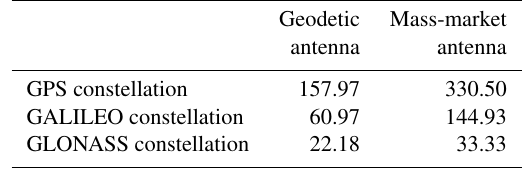
Table 1. Linear relationship (in degrees) between GNSS observa- tions and reference soil moisture observations.